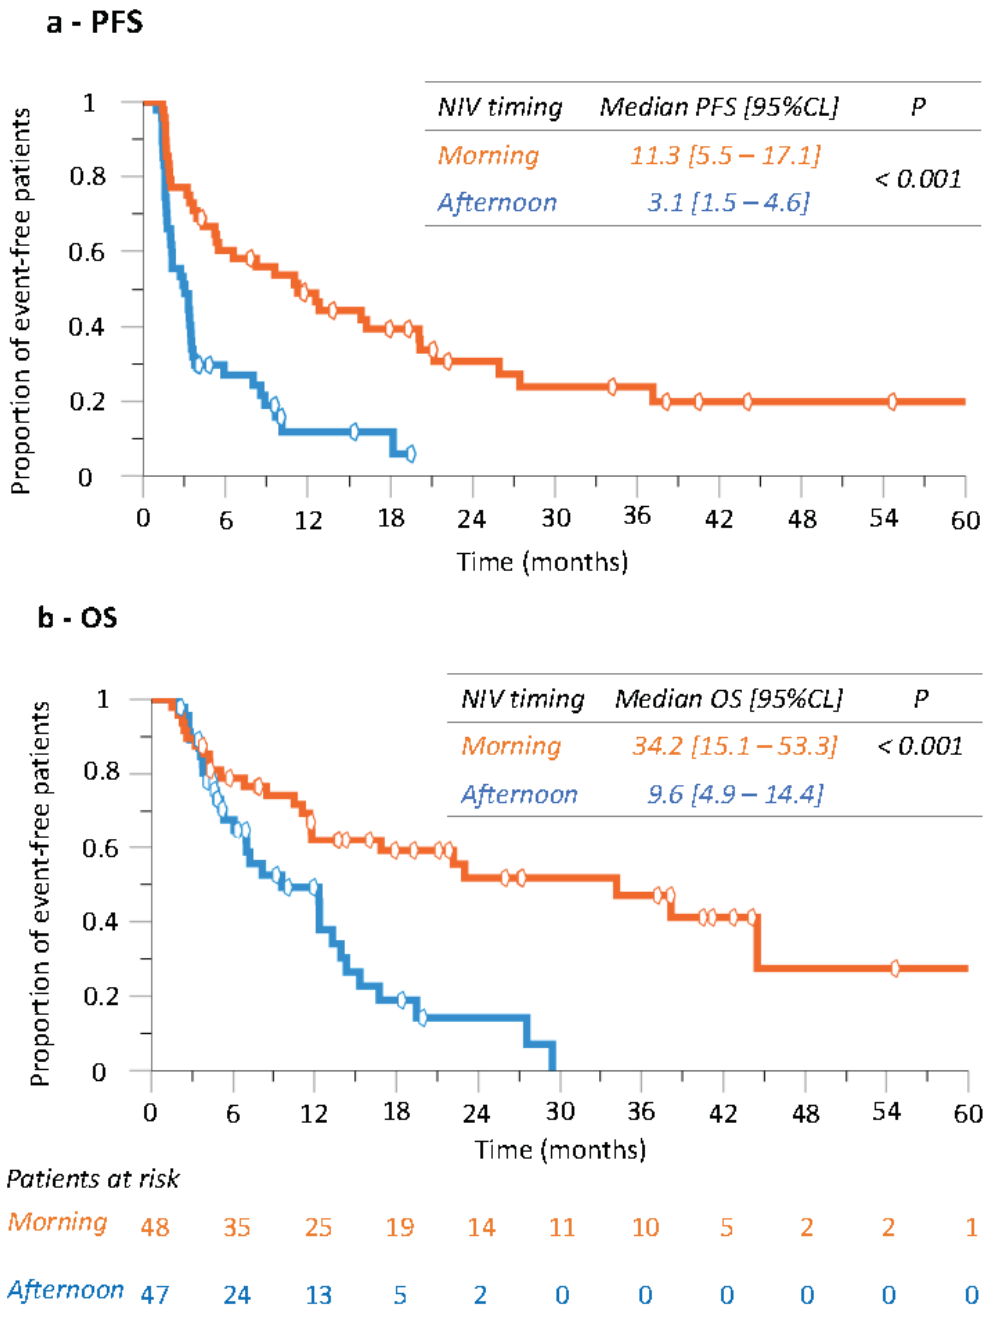
Figure 2. Kaplan–Meier curves of progression-free survival (PFS, ( a )) and overall survival (OS, ( b )) according to nivolumab timing group in whole study